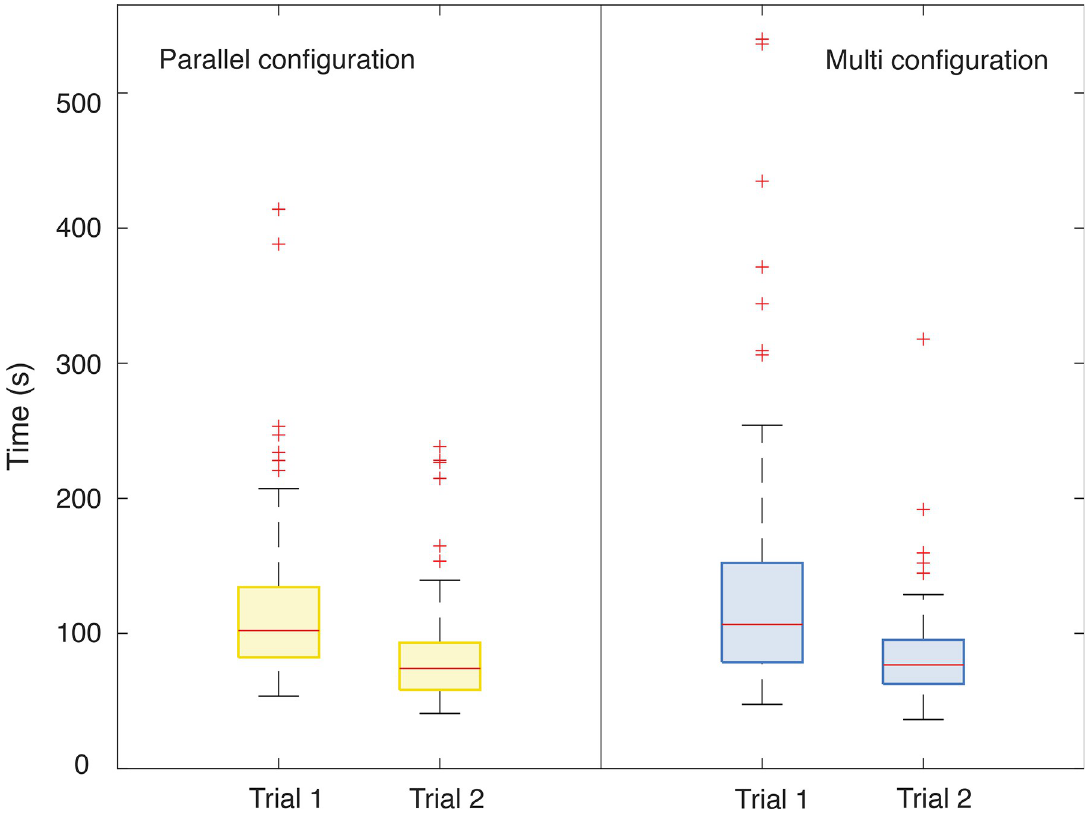
Fig 8. Box and whisker plots of the task performance time for the two cable configurations. Yellow represents the parallel configuration (PC), and blue the multi configuration (MC). For each instrument, the participants performed two trials. The red line in the box represents the median and the red crosses, the